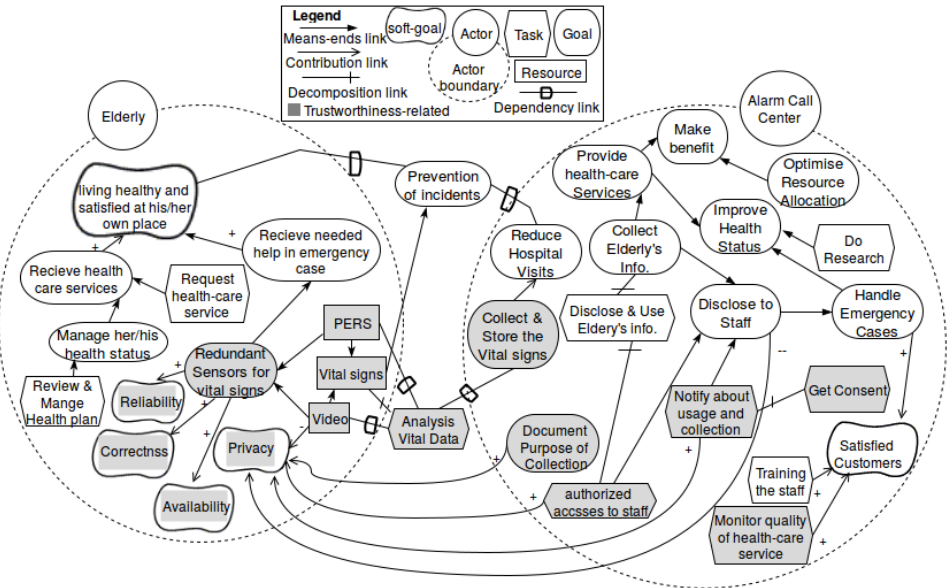
Figure 9. Simplified Strategic Rationale Model (SRM) including trustworthiness goals considering trust